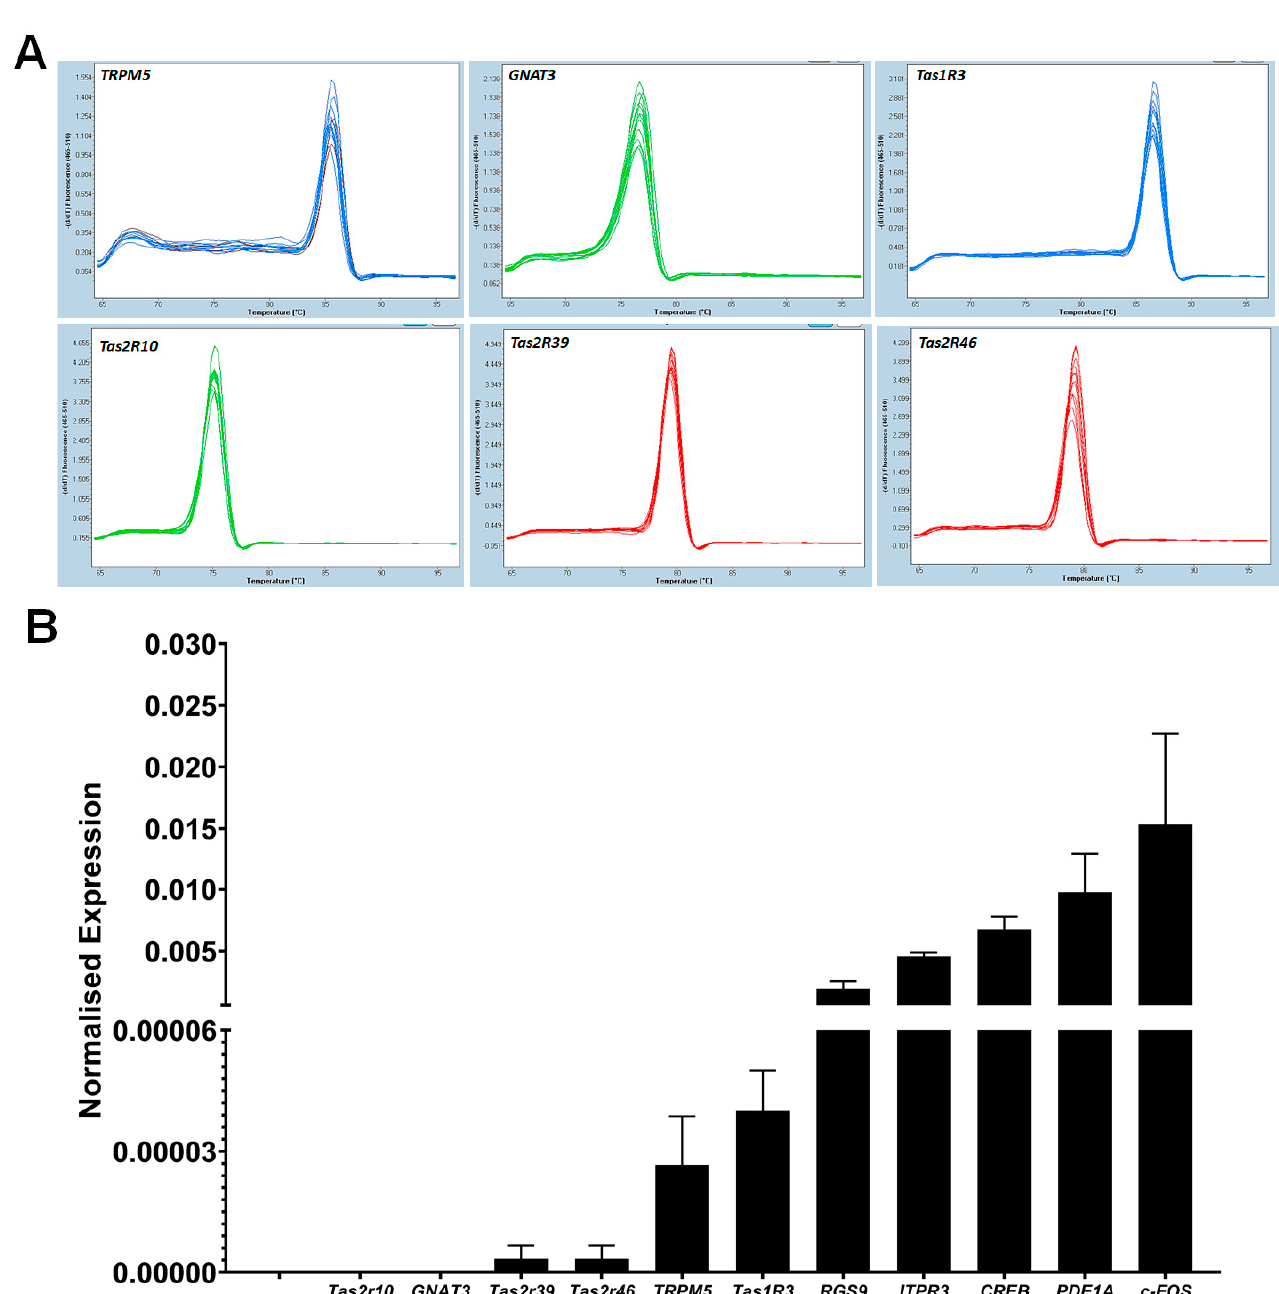
Figure 8. RT-qPCR analysis of taste specific genes; ( A ) melting curve analysis of taste specific genes; a single melting peak was observed for each target gene. The X-axis represents temperature (°C) and the Y-axis represents negative first derivative of fluorescence with respect to temperature ( − dF/dT). ( B ) Quantification of taste gene mRNAs using RT-qPCR; each cDNA was normalised to the reference gene PPIA and normalised expression level (y-axis) of each gene was quantified using 2 −Δ Cq method. Data are reported as mean of relative expression of three independent experiments and bars indicate standard error (±SE).